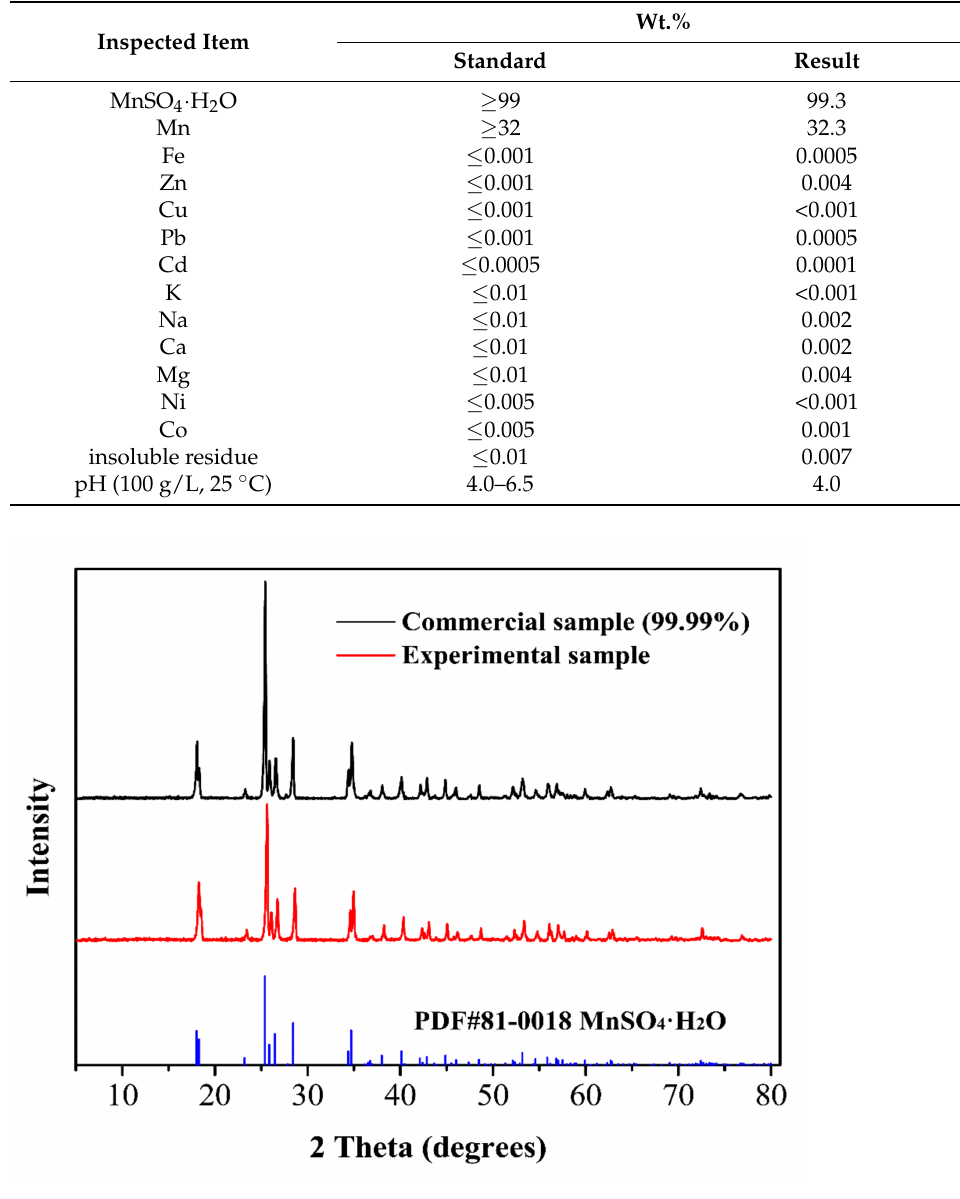
Figure 8. XRD comparison between MnSO 4 •• H 2 O crystals obtained in the experiment and commer- cial high-purity MnSO 4 • H 2 O